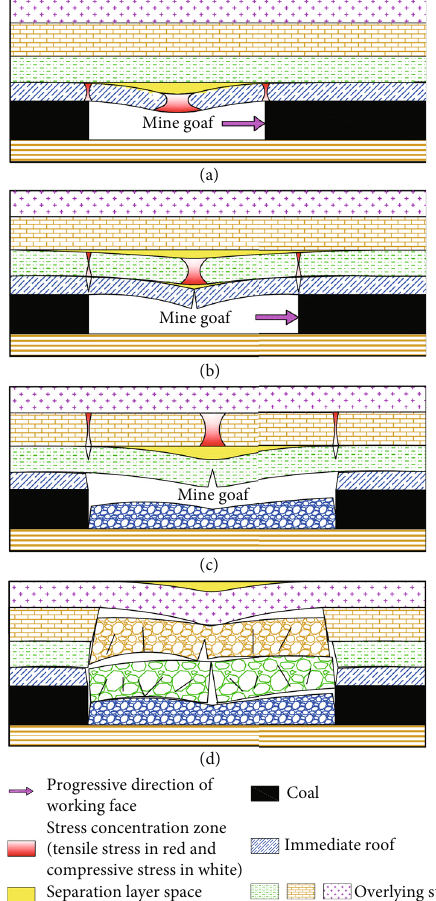
Figure 9: Generation and development mechanism of a water- conducting fracture zone. (a) Stress concentration occurs in the immediate roof when the working face advances. (b) Cracks appear in the immediate roof, and stress concentration occurs in the overlying strata. (c) The immediate roof collapse results in the development of cracks in the overlying strata. (d) Cracks cease to develop under the support of the collapse